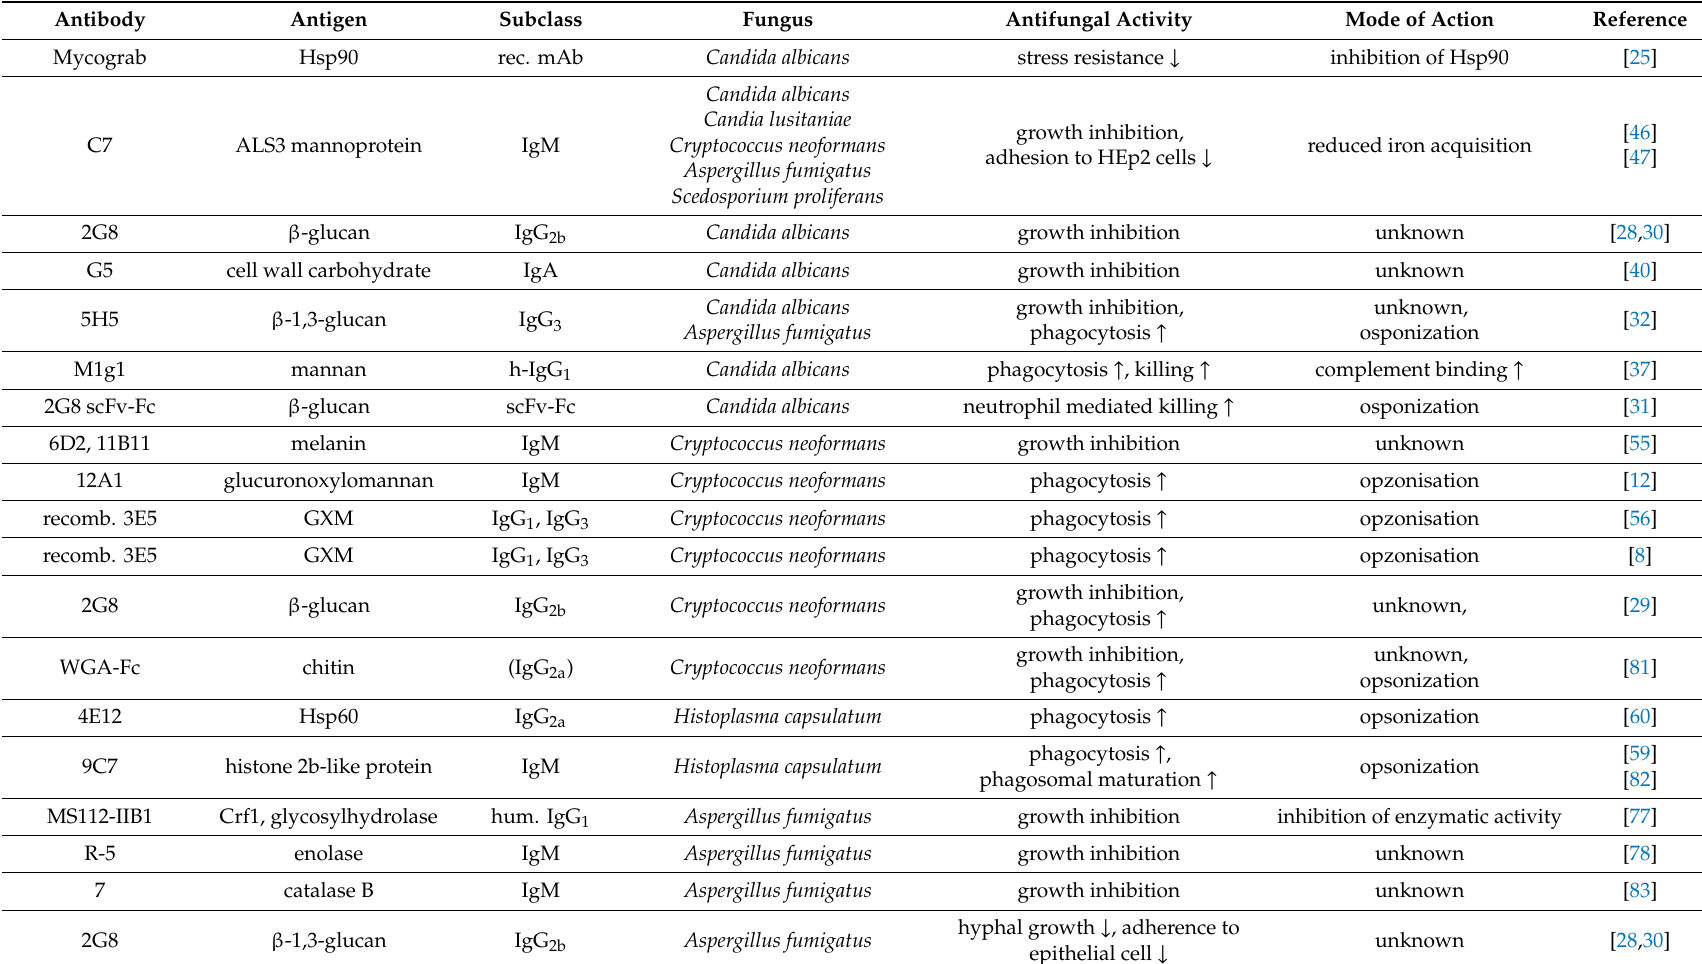
Table 2. Activities triggered by selected anti-fungal antibodies in